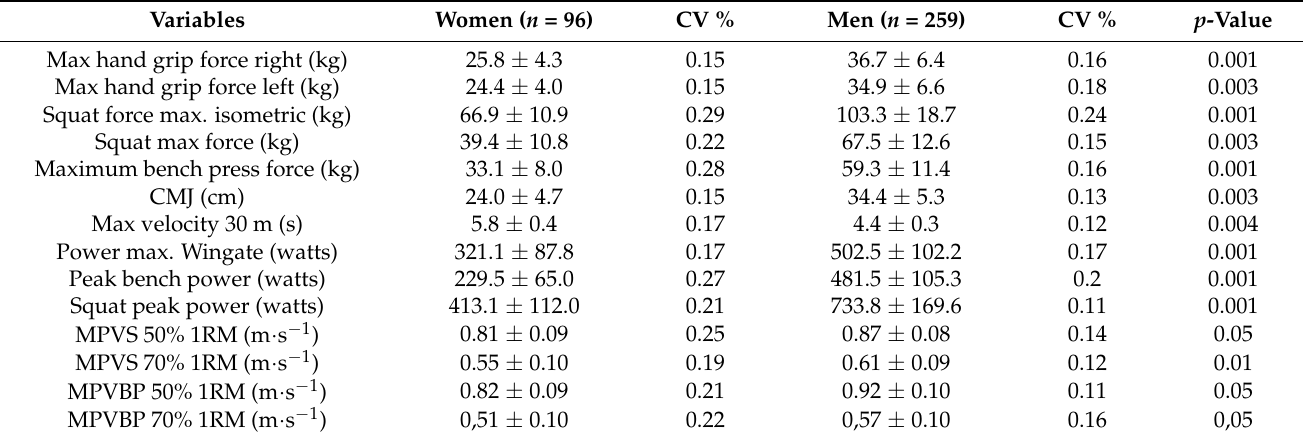
Table 1. Values obtained (mean and SD) in the different evaluations of strength and